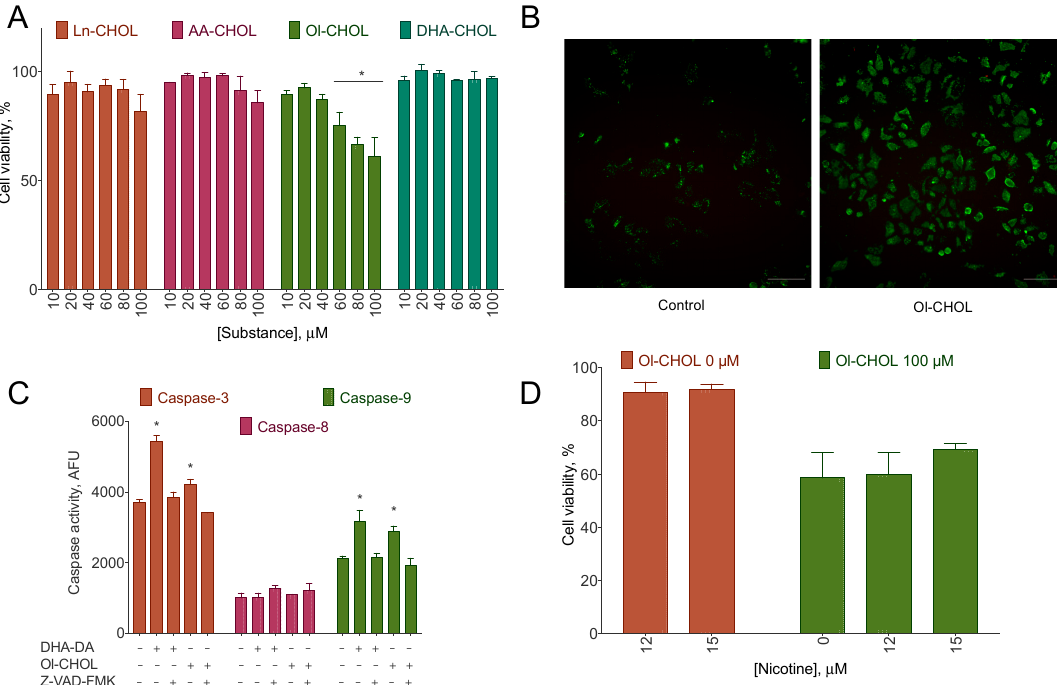
Figure 5. A549 lung cancer cell line viability inhibition by acylcholines. The cells were incubated with the substances for 24 h. Cell viability was determined using an MTT test. ( A ) the cytotoxicity of acylcholines. In the ANOVA with the Tukey post-hoc test, the survival of the cells at the Ol-CHOL concentration 100 μ M differed statistically significant from other acylcholines with p < 0.05. Mean ± standard deviation, N = 3 experiments; ( B ) Apoptosis induction by 150 μ M of Ol-CHOL, green phosphatidylserine sensor fluorescence, red membrane-impermeable nucleus stain 7-AAD, fluorescence microscopy, scale bar is 100 μ m; ( C ) Caspase activation after 5 h incubation with either 100 μ M of N -docosahexaenoyl dopamine (DHA-DA, positive control) or 150 μ M of Ol-CHOL with or without 100 μ M of the pan-caspase inhibitor Z-VAD-FMK, fluorescence of hydrolyzed specific substrates Ac-DEVD-AFC (Caspase 3), Ac-LEHD-AFC (Caspase 9), and SCP0139 (Caspase 8). Mean ± standard deviation, N = 3 experiments. *, a statistically significant difference from the untreated control; ( D ) the cytotoxicity of Ol-CHOL in the presence of nicotine. Mean ± standard deviation, N = 3 experiments.